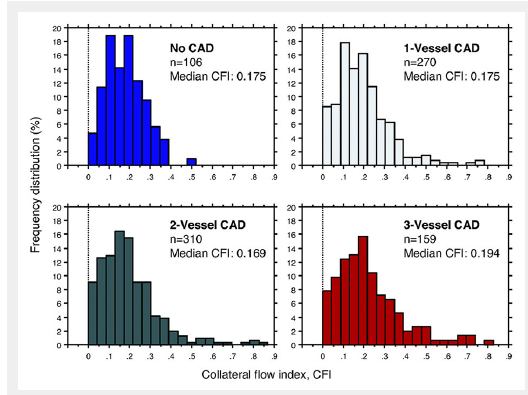
Frequency distribution (vertical axes in percent) of collateral flow index (CFI, horizontal axes) in patients without coronary artery disease (CAD; top left) and with increasing severity of CAD. Sufficient collaterals by CFI are present in a fourth of patients with angiographically normal coronary arteries, whereas this proportion increases to one third in patients with CAD.